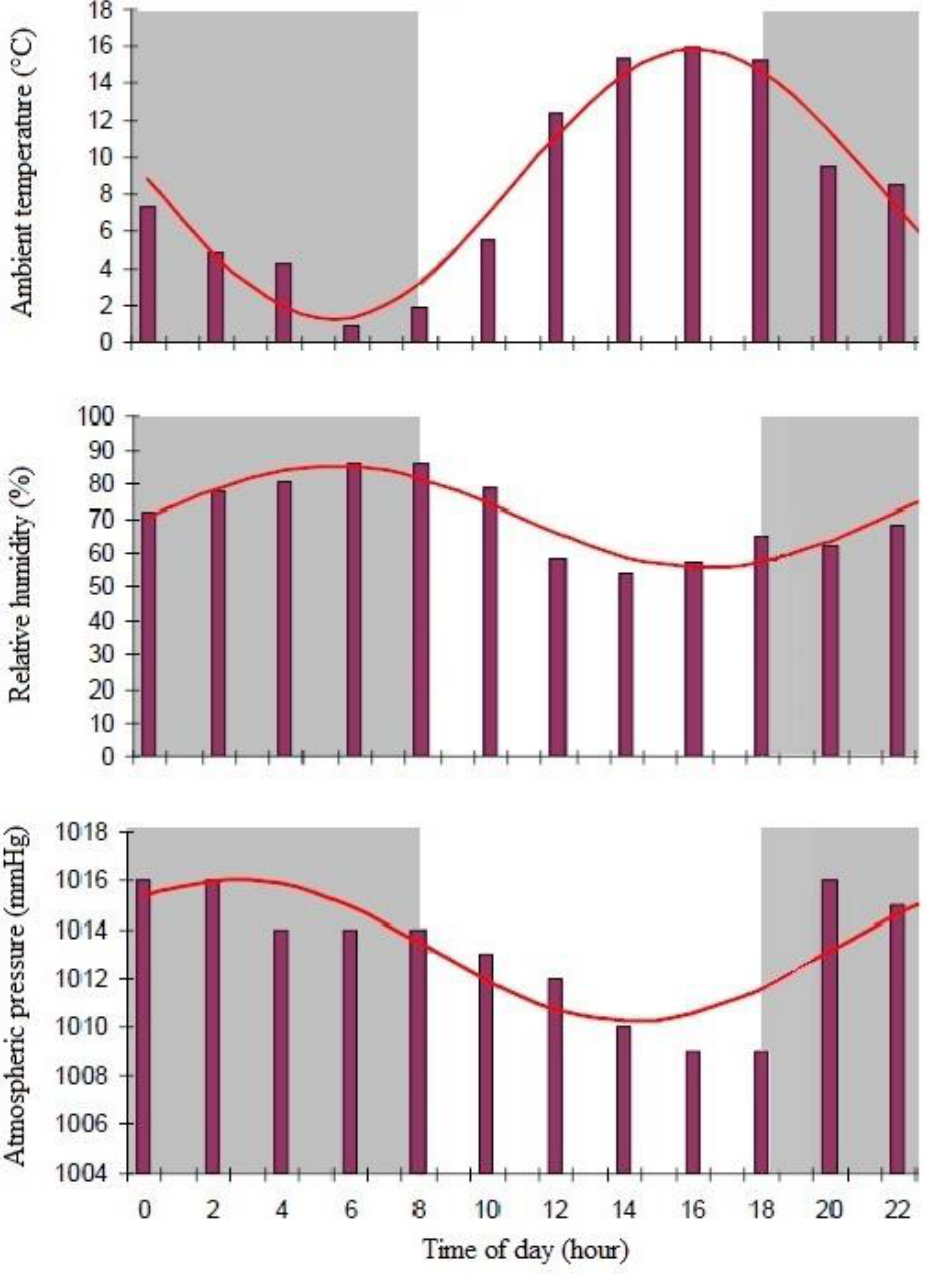
Figure 1. Rhythmic patterns of climatic variables during the trial of Holstein calves at 30 days of life subjected to natural conditions with periods of light – dark cycle 10L:14D. (Cont.) Y = A0 + A1 × Cos (w × t +